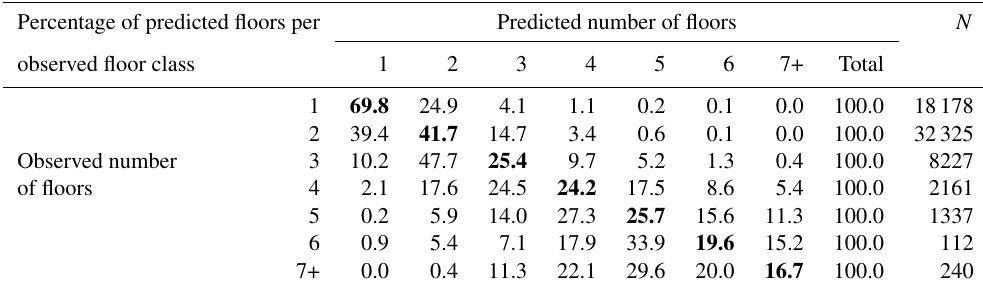
Table 4. Hit rate of predictions of the number of floors for Polish residential buildings at risk of sea level rise and coastal floods. Bold font indicates the percentage of the correctly predicted number of